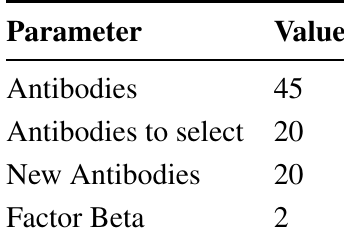
Table 3. Parameters of